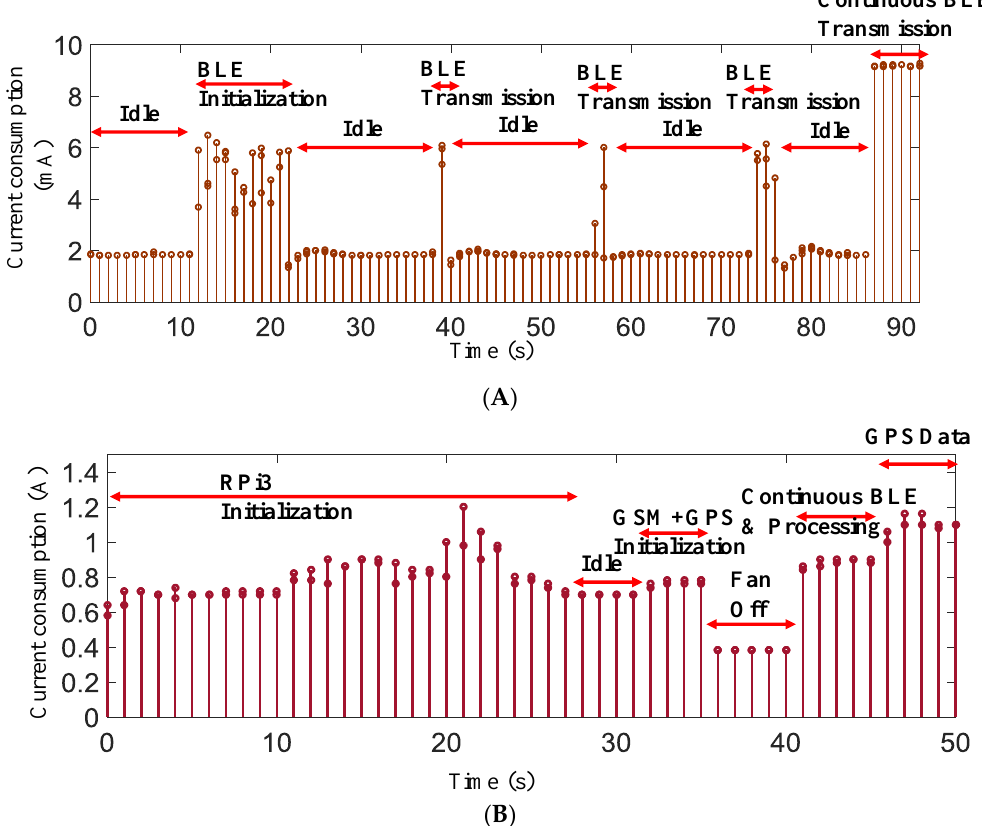
Figure 13. Current consumption in different operational scenarios for the wearable subsystem ( A ) and the RPI3 subsystem ( B ).